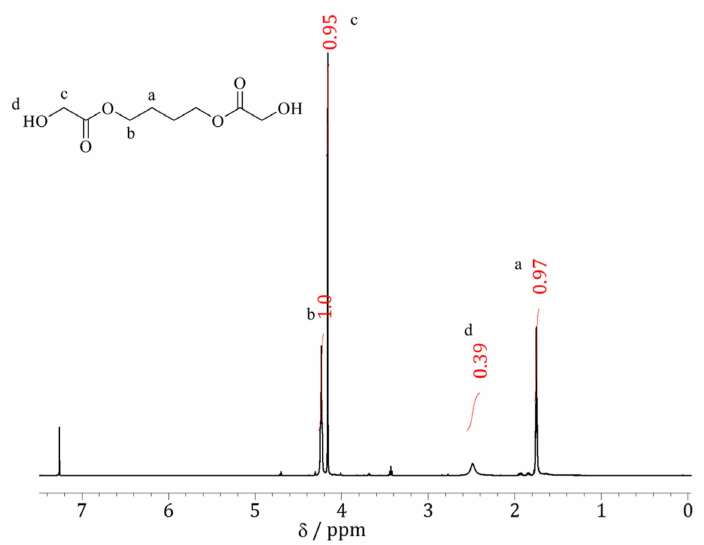
Figure 1. 1 H NMR spectrum of GBG (CDCl 3 , 500 MHz, r.t.). Red color: relative